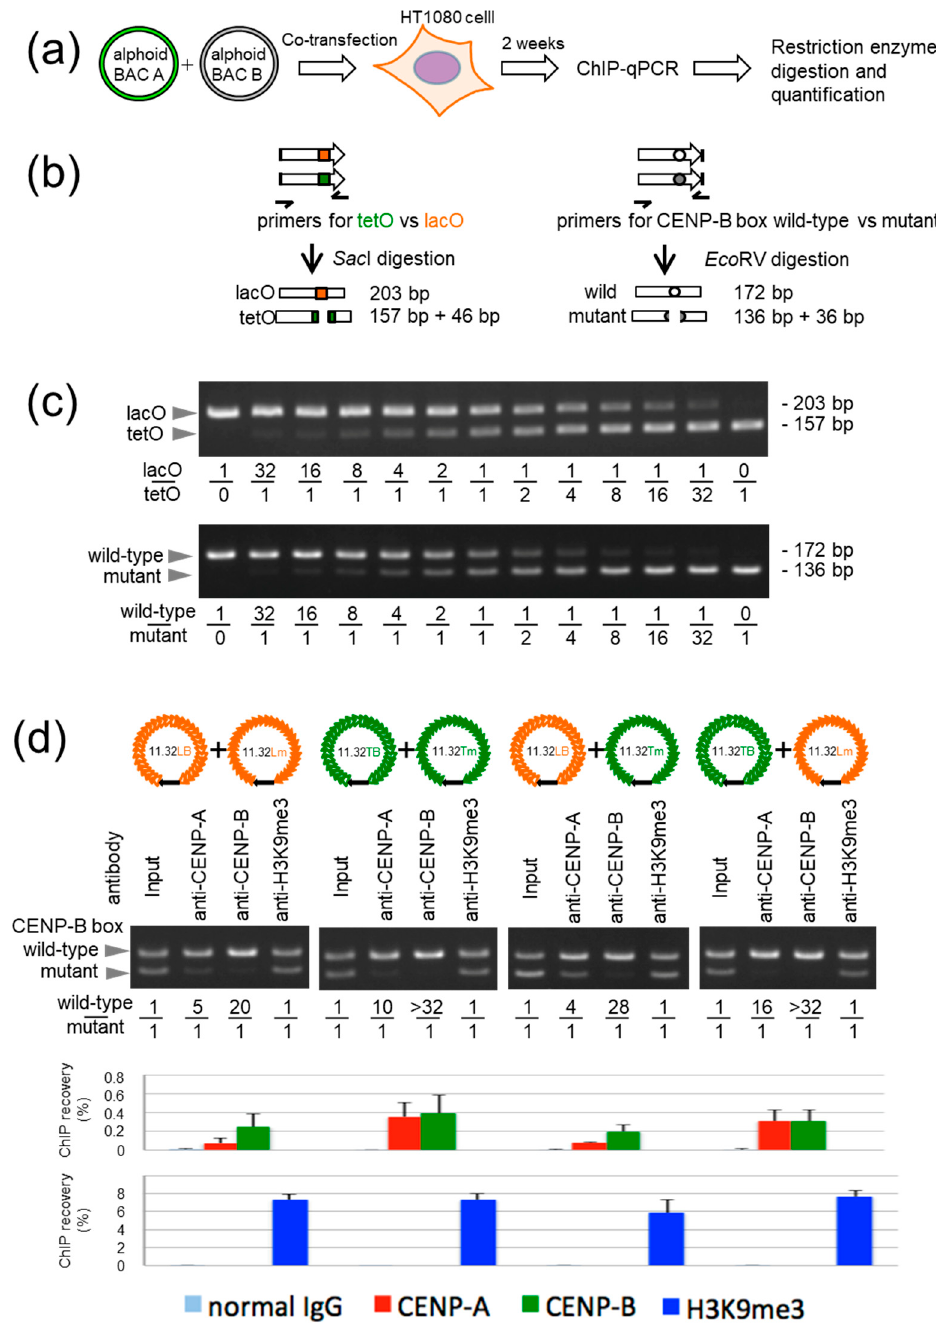
Figure 2. De novo CENP-A chromatin formation efficiency and effectiveness of fusion protein tethering on synthetic alphoid arrays. ( a ) Diagram of the transient ChIP assay to evaluate CENP-B-dependent CENP-A chromatin formation. ( b ) Diagram of the competitive PCR to quantify the ratio of the two types of alphoids within the immunoprecipitated chromatins. ( c ) Reference gel used to quantify the ratio of the two types after 35 cycles of PCR. ( d ) Top, combinations of the four types of synthetic alphoid arrays introduced into HT1080 cells and subjected to ChIP analysis 2 weeks after transfection. Middle, results of the competitive PCR. Bottom, results of qPCR. For the competitive PCR, the intensities of the 172-bp bands for the CENP-B box wild-type alphoids and 136-bp bands for the mutant alphoids were quantified according to the reference gel in ( c ). Error bars indicate standard deviation ( n = 3).